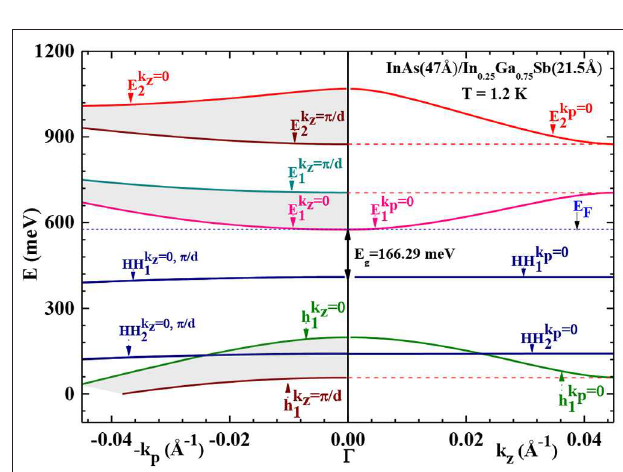
FIGURE 2 | Energy position and width of E i , HH i and hi subbands calculated at 1.2 K, in the FBZ as a function of d 1 .